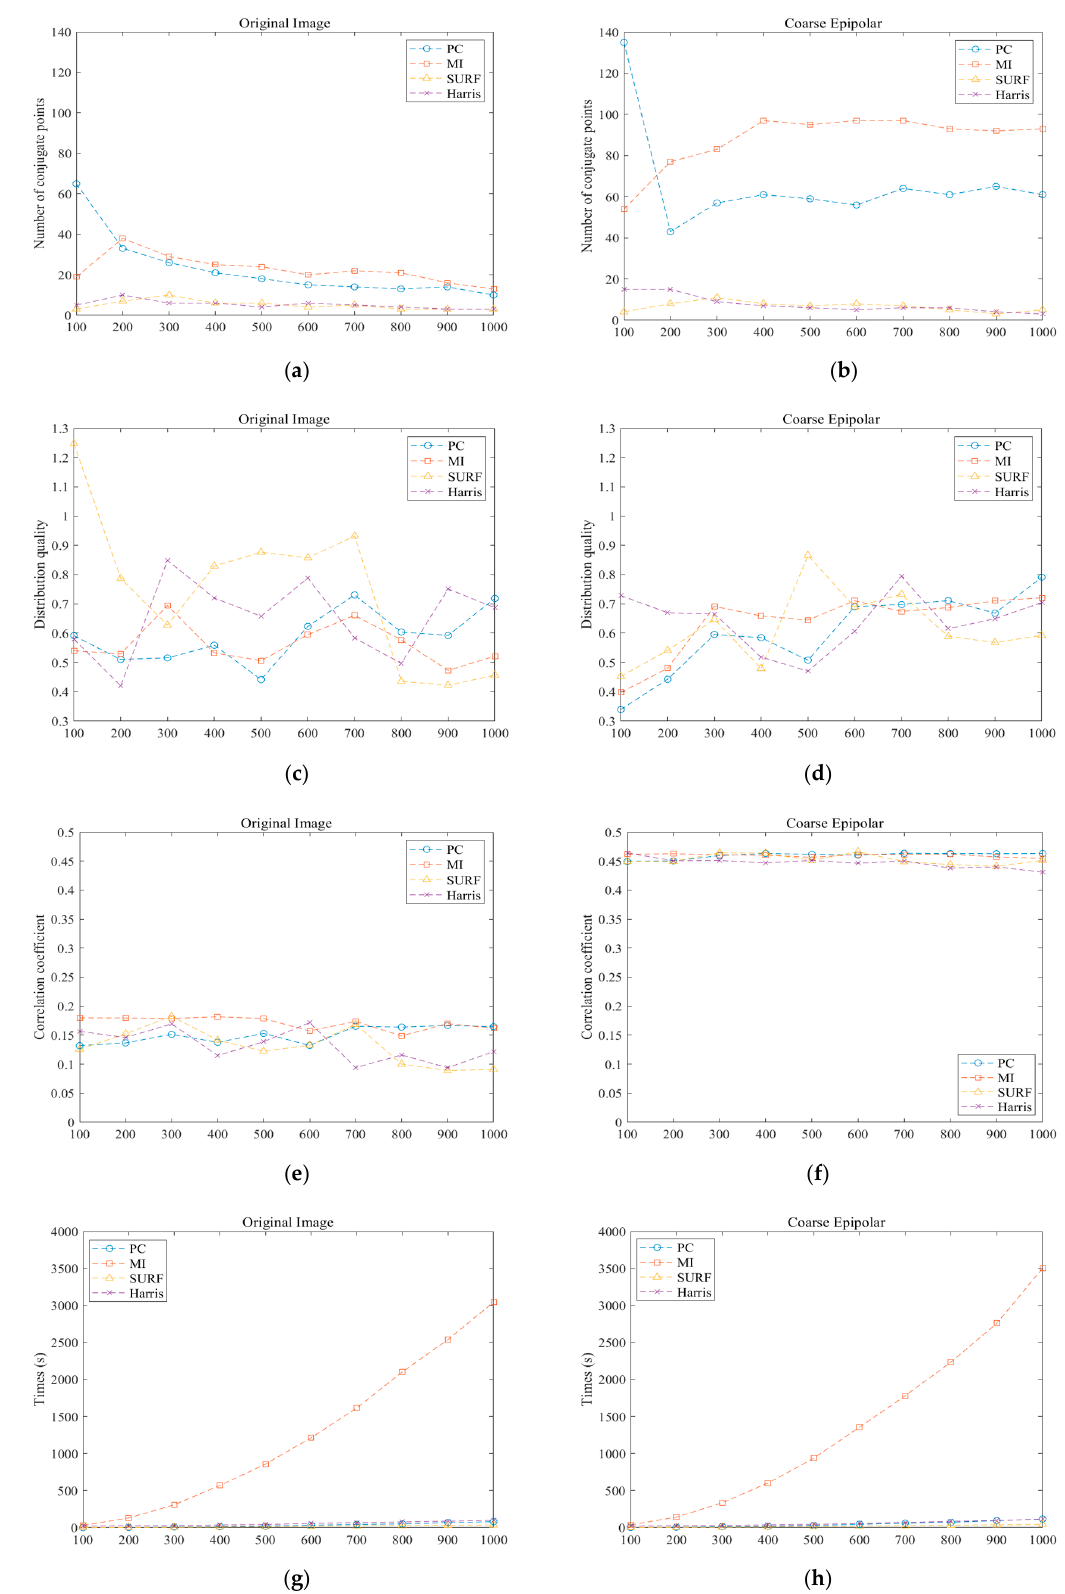
Figure 9. Results of matching point extraction (across-track Kompsat-3A stereo data): ( a , b ) number of conjugate points, ( c , d ) distribution quality, ( e , f ) correlation coefficient ( g , h ) process times in original and coarse epipolar images, respectively.